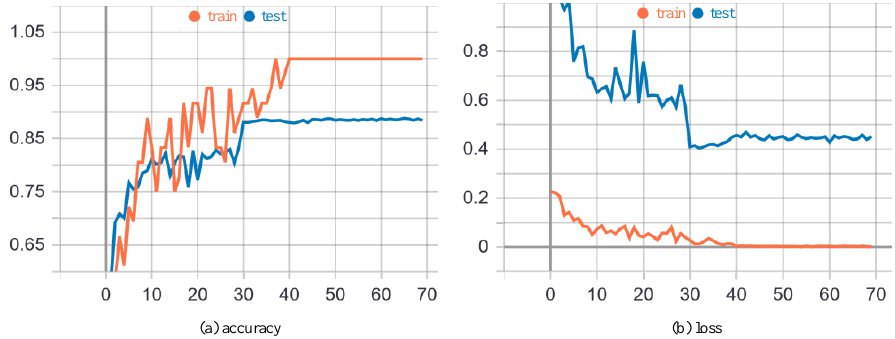
Figure 5. The performance and convergence speed of our EEGCN on the X-Sub setting in training process. The x-axes of ( a , b ) are the numbers of epochs. The y-axes of ( a , b ) are the recognition accuracy and cross-entropy loss